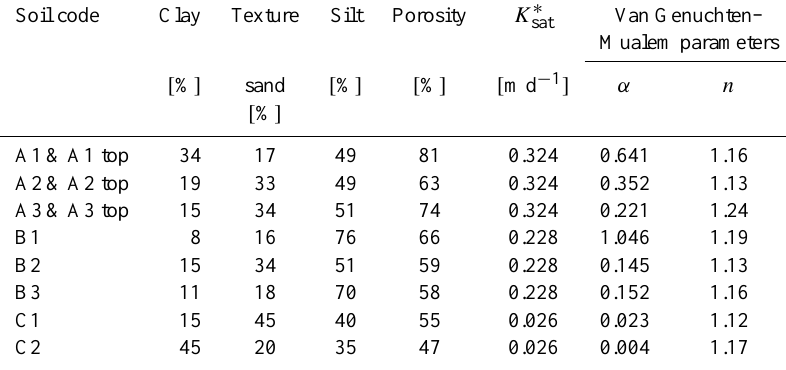
Table 1. Soil physical parameters. Soil code Clay Texture Silt Porosity K ∗ sat